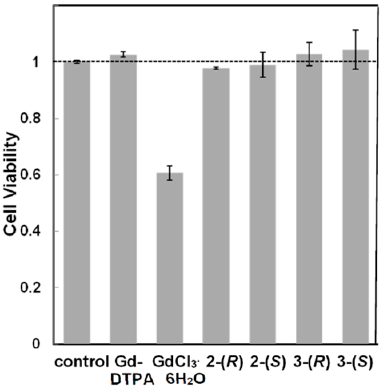
Figure 3. Viabilities of L929 cells 24 h after incubation with Gd-DTPA, GdCl 3. 6H 2 O, 2 -( R ), 2 -( S ), 3 -( R ) and 3 -( S ) (0.25 mmol/L).